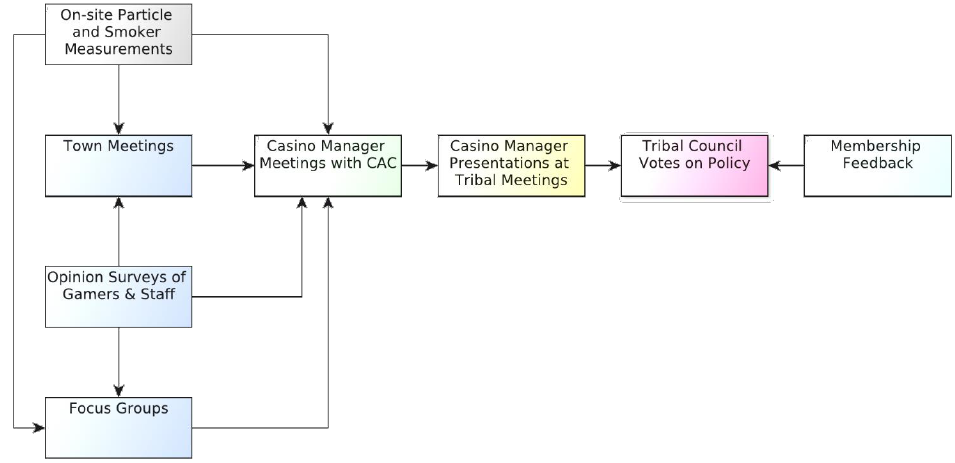
Figure 2. Diagram showing the linkages between material elements of the policy